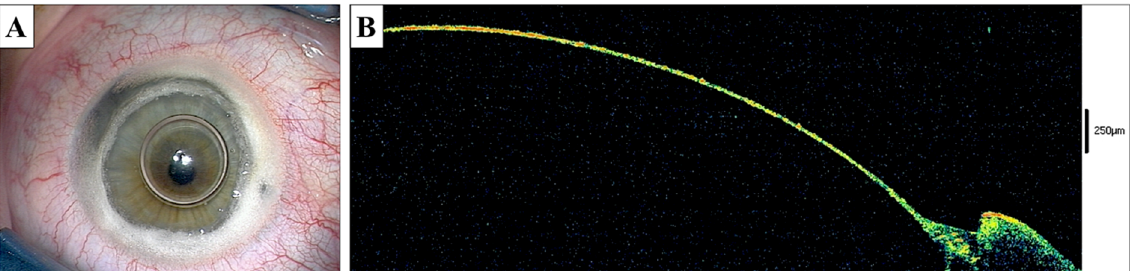
Figure 1. Big Bubble DALK procedure. A— The recipient’s bed prepared after intrastromal air injection and anterior corneal layer excision, the smooth Descemet’s surface visible over the air bubble in the anterior chamber. B— Intraoperative anterior OCT scan of the recipient’s bed showing the remaining tissue at approximately 20 µm of thickness.